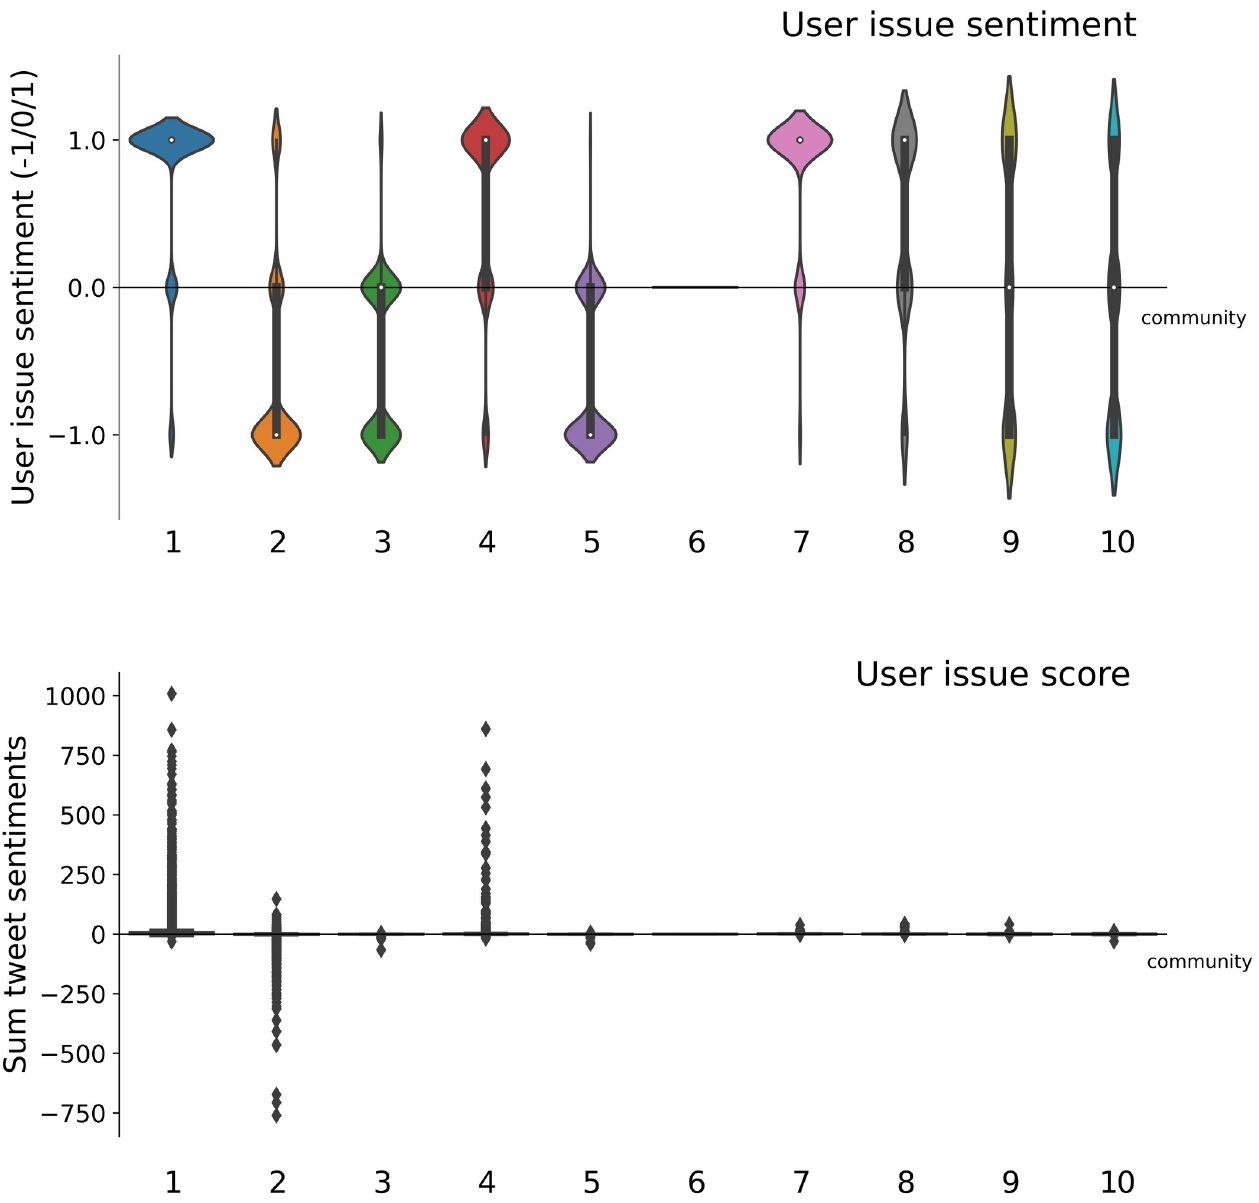
Fig 9. Distribution communities’ issue sentiment. The distribution of users’ issue sentiment in favor (1) or against (-1) Black Pete per community. The top panel gives the final user issue sentiment by the majority rule (-1,0 or 1 per user). The bottom panel gives the users’ issue score, calculated by the sum of users’ tweet sentiments. This shows communities 1, 2 and 4 contain a number of highly active users with a strong sentiment on Black Pete.